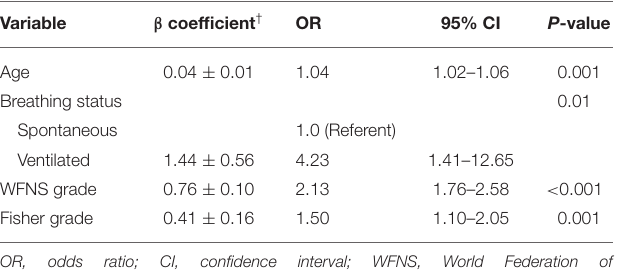
TABLE 2 | Results of multivariate logistic regression analysis.